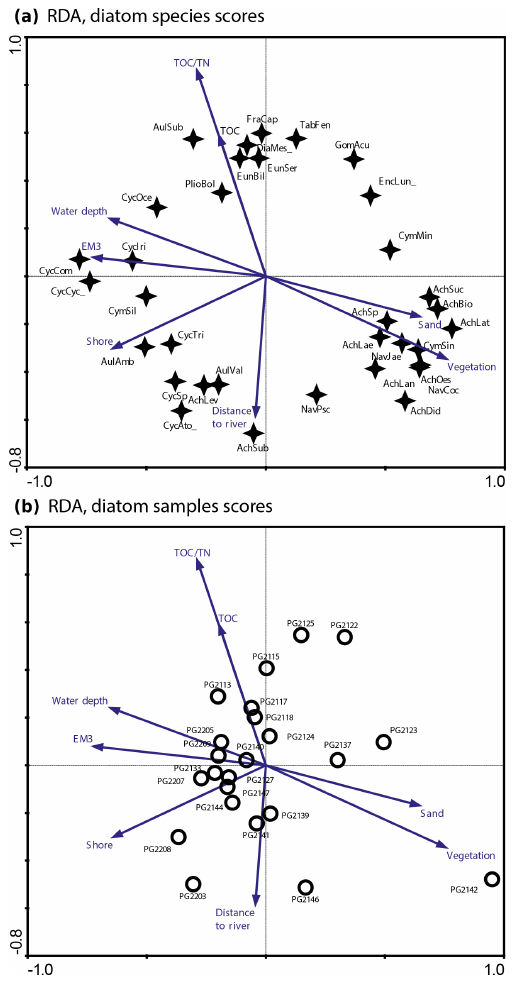
Figure 2. RDA biplots of diatoms in the surface sediments of Lake Bolshoe Toko. (a) Common diatom taxa and significant environ- mental variables. (b) Diatom sampling sites and significant